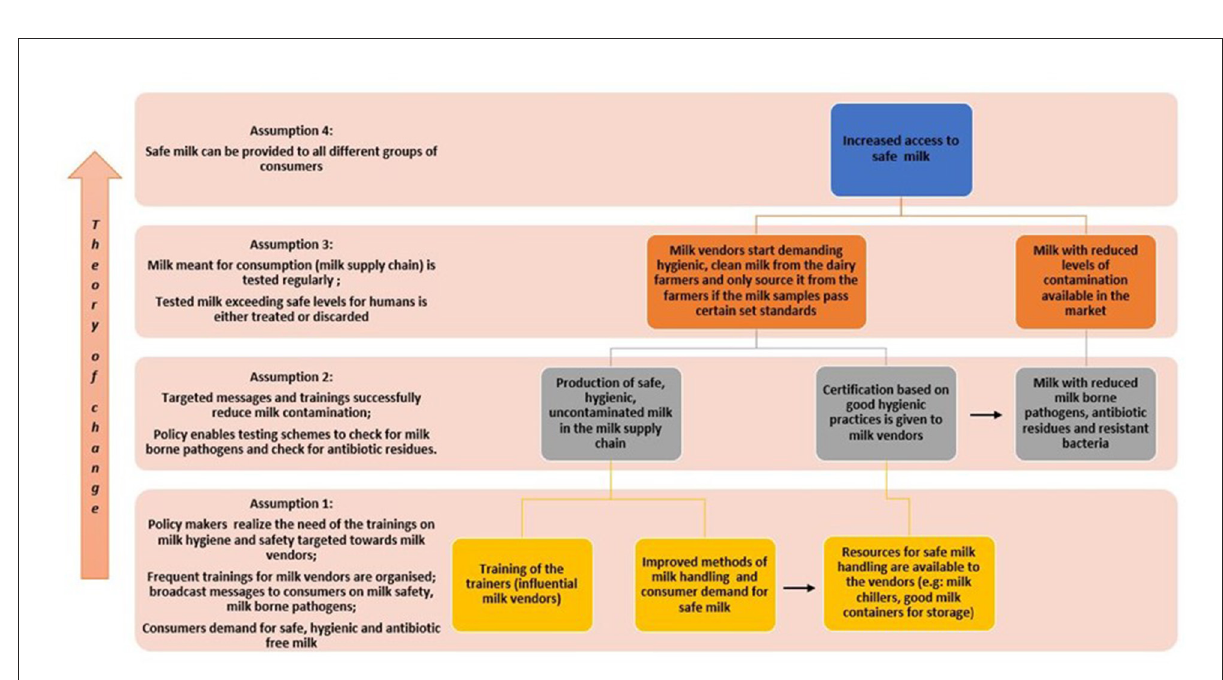
FIGURE6 A theory of change for how milk vendor intervention can affect milk safety, including assumptions 1–4 listed on the left, actions, and outcomes flow from the bottom of the diagram upwards.